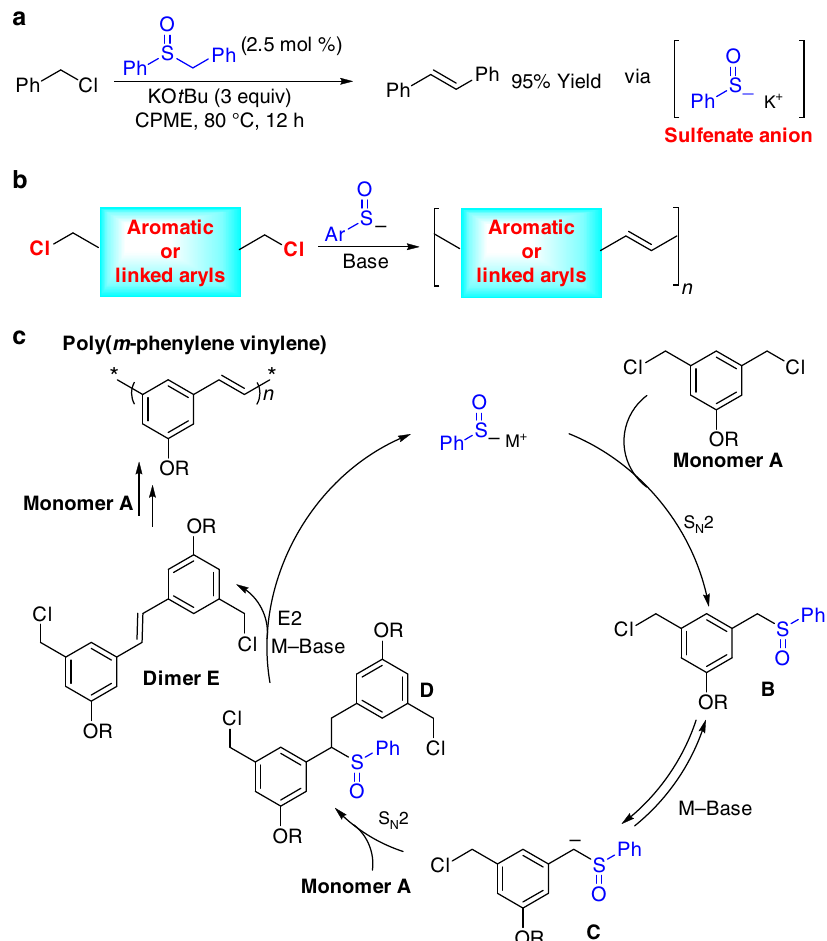
Fig. 1 Sulfenate anion-catalyzed reactions. a Dehydrocoupling of benzyl chlorides to produce stilbenes. b Generic representation of the benzylic chloromethyl-coupling polymerization (BCCP), where the blue box represents an aromatic system or tethered aromatic rings. c Fundamental steps in the organocatalytic